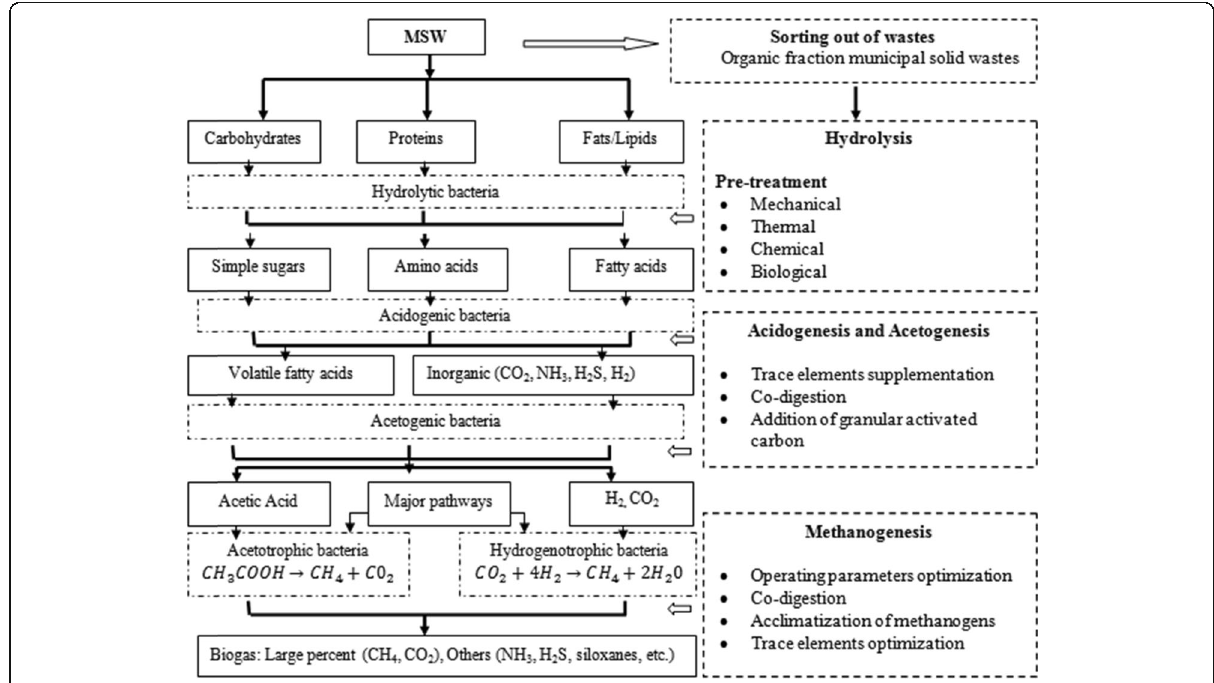
Fig. 1 Strategies to improve metabolic stages of the anaerobic digestion process of organic fraction municipal solid